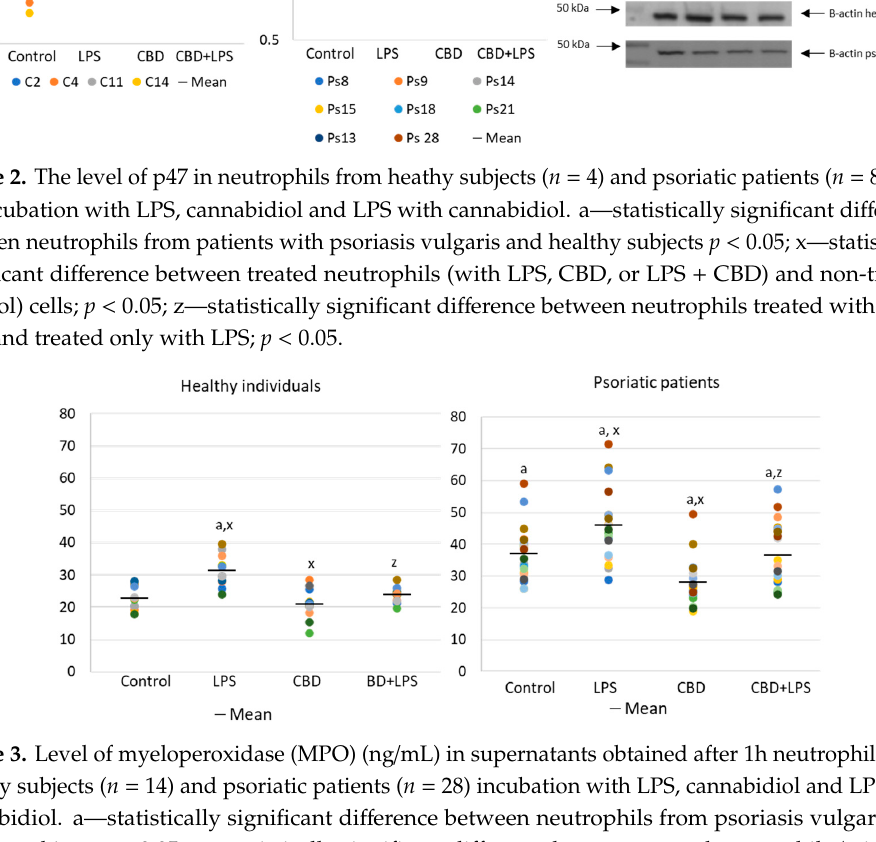
elastase was much greater in neutrophils of patients with psoriasis than in healthy subjects, leads to a reduction in the production of elastase in neutrophils of psoriasis patients. It can therefore be suggested that CBD reduces the effect of LPS on plaque neutrophils (Figure 5). Figure 5. Neutrophil elastase expression in human neutrophils from heathy subjects ( n = 4) and psoriatic patients ( n = 8) after 1 h incubation with LPS, cannabidiol and LPS with cannabidiol. a—statistically significant difference between neutrophils from patients with psoriasis vulgaris and healthy subjects p < 0.05; x—statistically significant difference between treated neutrophils (with LPS, CBD, or LPS + CBD) and non-treated (control) cells; p < 0.05; z—statistically significant difference between neutrophils treated with LPS + CBD and treated only with LPS; p < 0.05. Since the action of the described enzymes ultimately leads to the release of the DNA, cfDNA it is one of the most reliable markers of NETosis. In the present study, an increase in the concentration of cfDNA was observed in supernatants obtained after incubation of neutrophils from psoriasis patients as well as after incubation of neutrophils with LPS. On the other hand, CBD leads to a